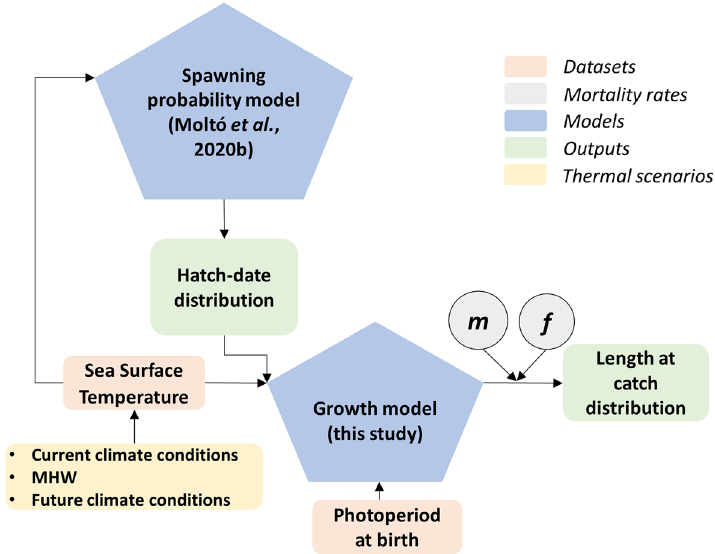
Figure 1. Conceptual scheme of the IBM used to project the fish size distributions under future thermal scenarios and an observed MHW, considering ecological processes and fishery drivers. Created with Microsoft PowerPoint, 2011 (https:// www. micro soft. com/ es- es/ micro soft- 365/ power